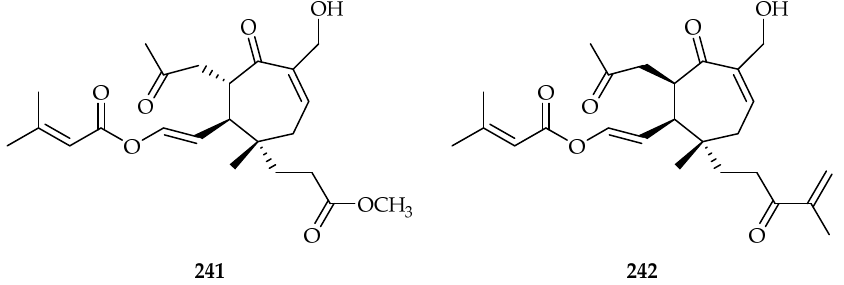
Figure 95. Structures of vibsanolid B 241 [149] and C 242 [149].